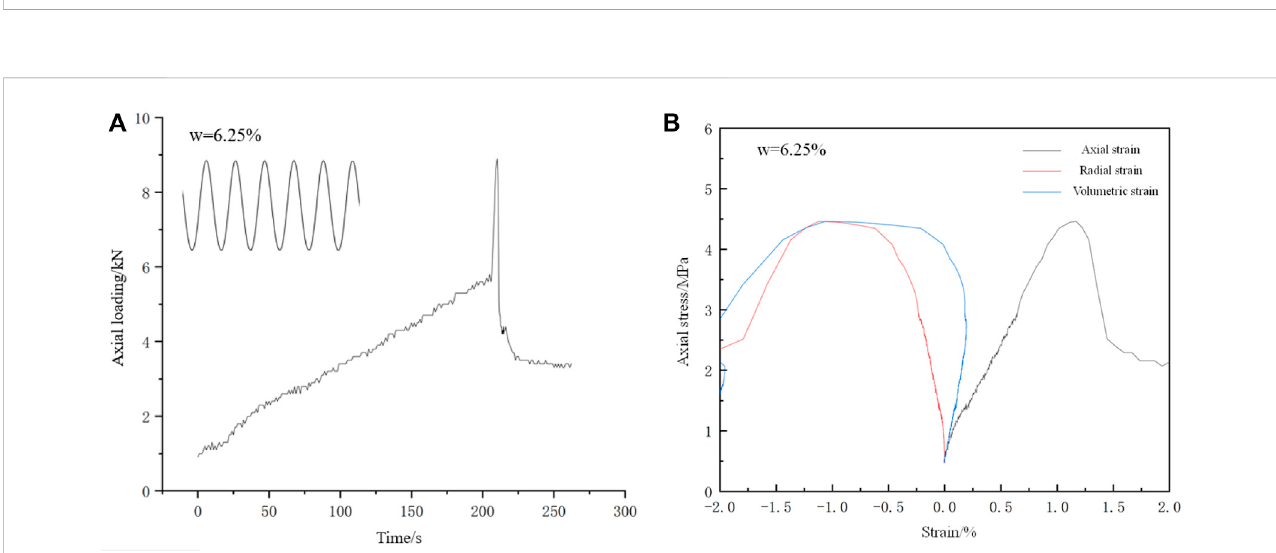
FIGURE 5 Theloadingpathandcompletestressstrainresponseswithmoisturecontentofw=6.25%. (A) Theloadingpath; (B) Theaxial,radialandvolumetricstress strain